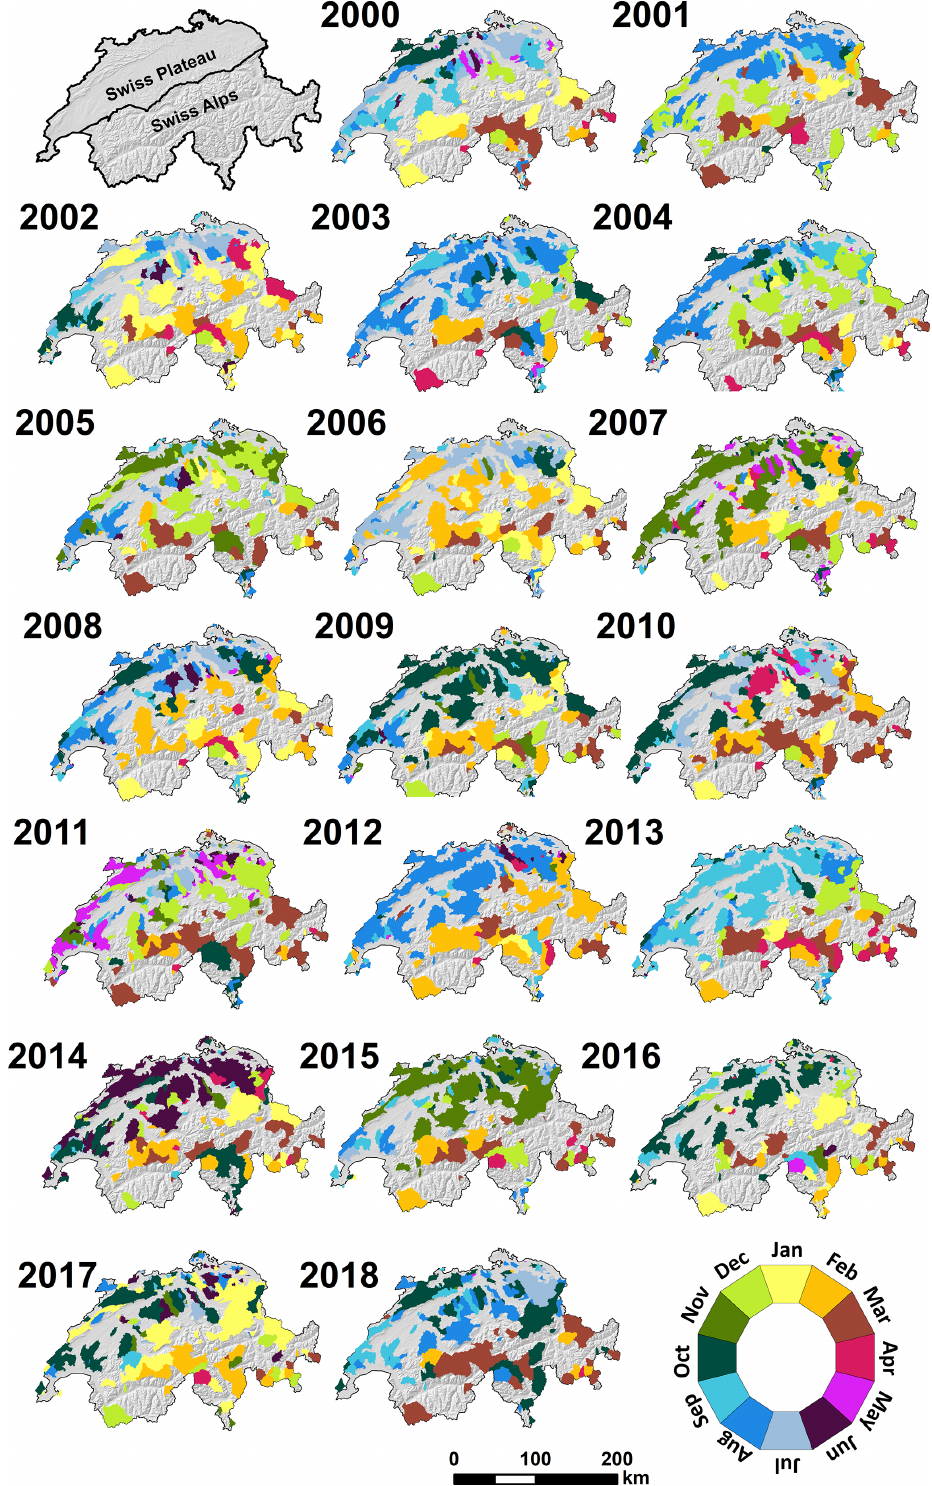
Figure 1. The timing of the occurrence of annual low flows across Switzerland for the years 2000 to 2018 in the two main regions, namely the Swiss Plateau and Swiss Alps (roughly the northern and southern halves of the country, respectively). Low-flow timing tended to be spatially heterogeneous – even in years when large parts of Europe simultaneously experienced severe low flows (2003, 2011, 2015 and